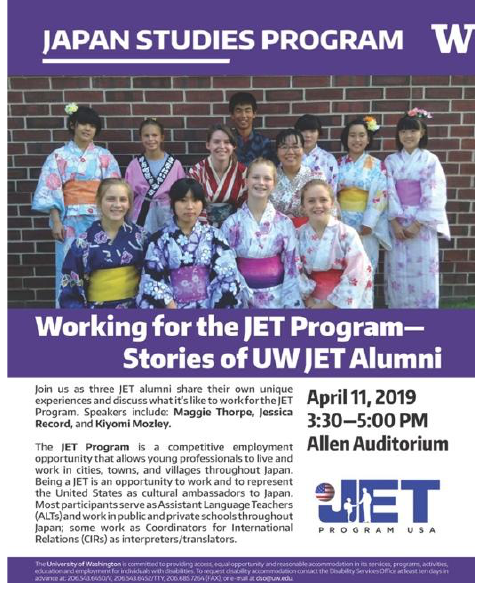
Figure 2. Flyer for a Recent Talk by JET Program Alumni. Used with